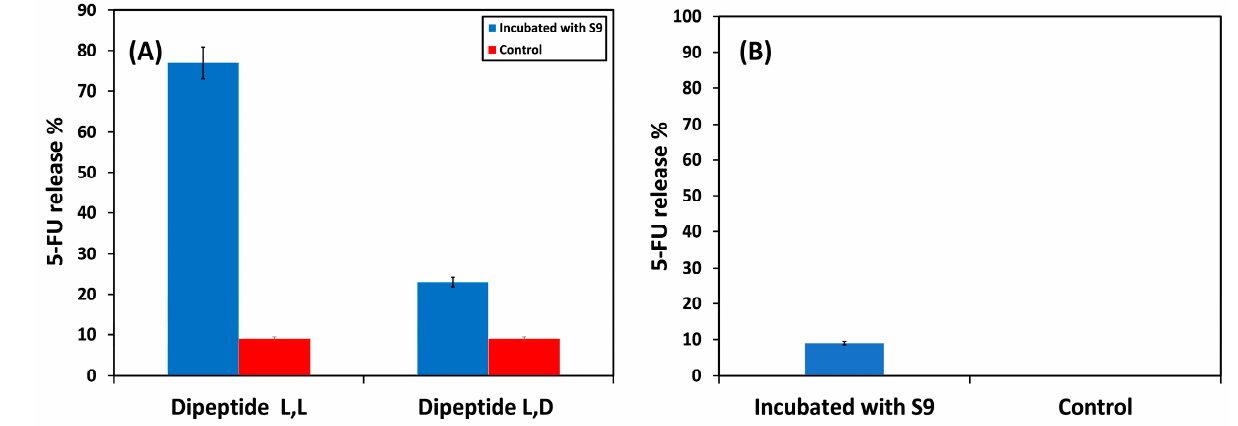
Figure 4. Incubation of ( A ) dipeptide derivatives of 5-FU and ( B ) 5-FU polymer conjugate with the liver S9 fraction at 37 °C pH 7.4 for 24 h.